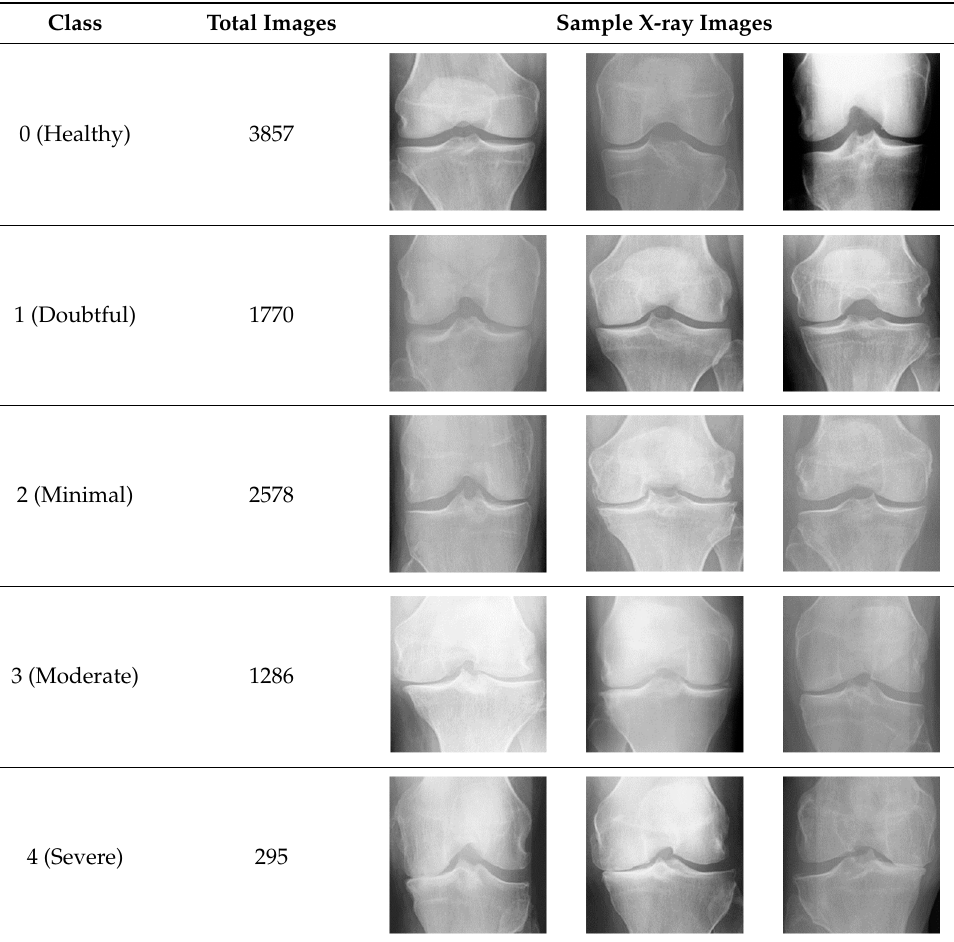
Table 2. Samples images of each class from the OAI dataset.